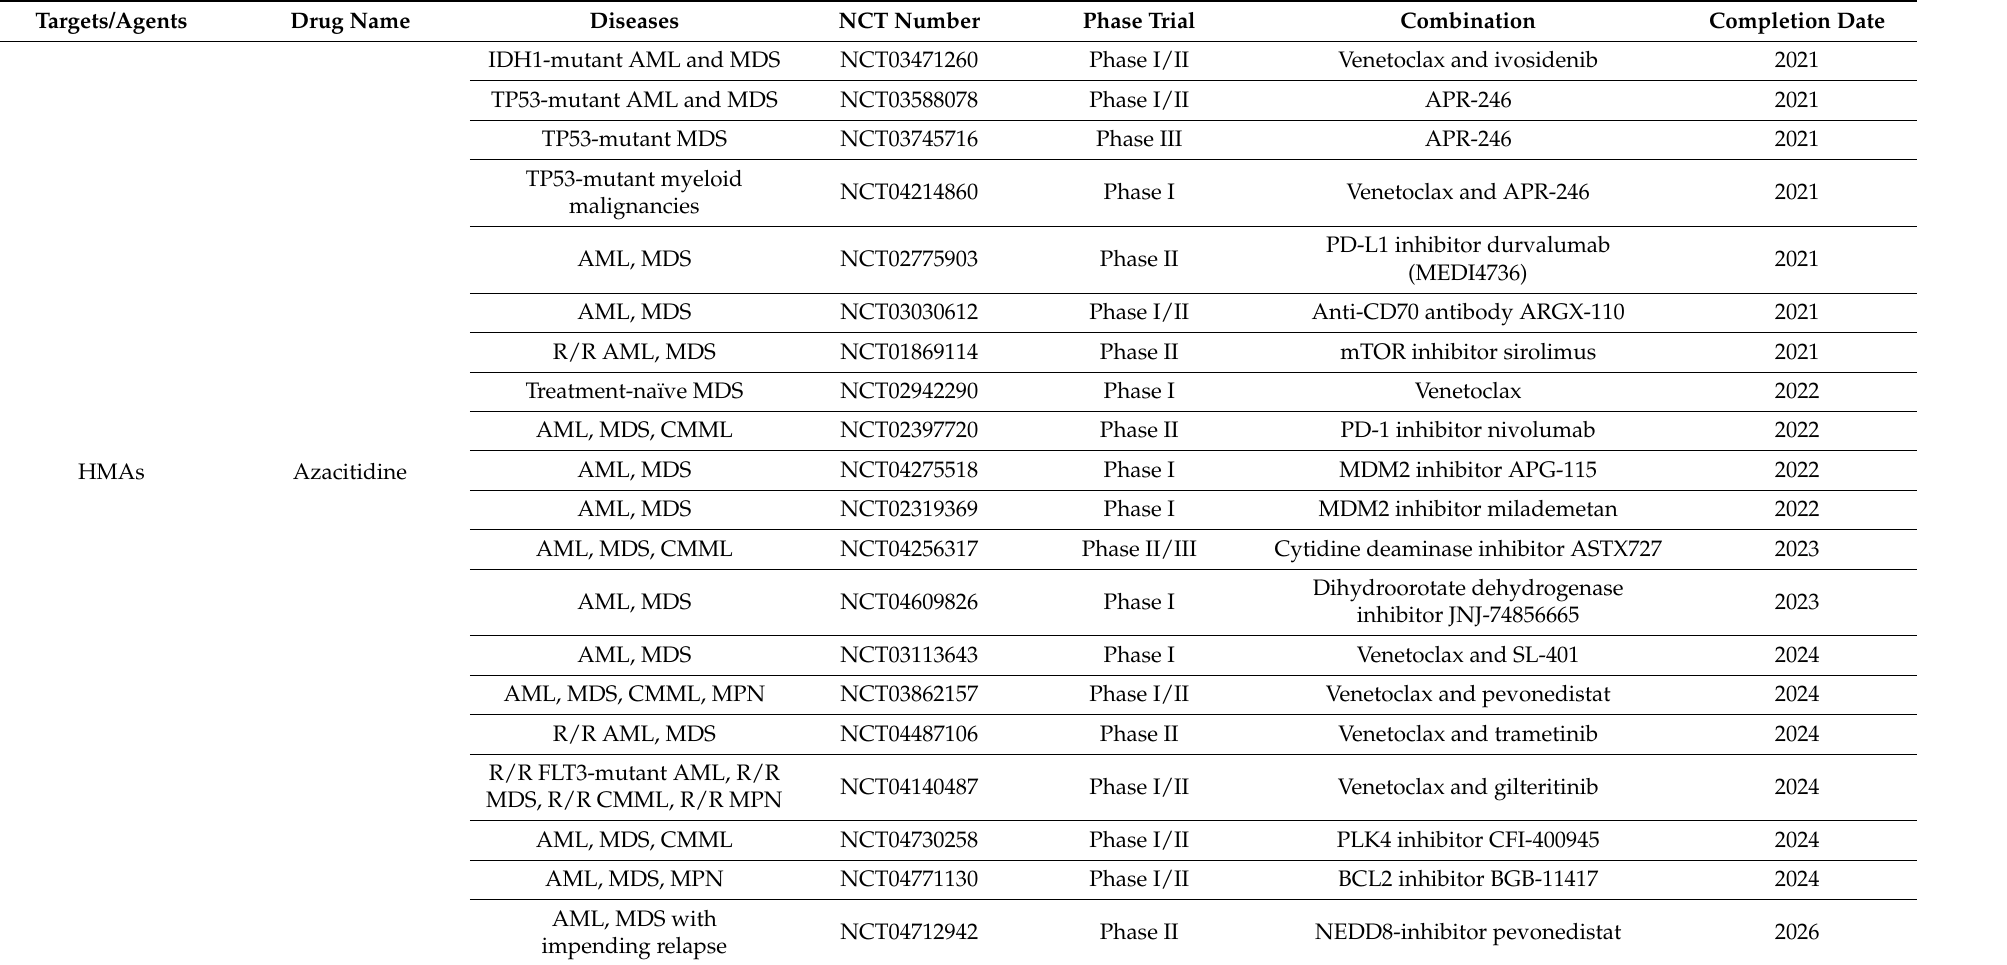
Table 3. Ongoing or recently completed clinical trials using epigenetic drugs in the treatment of myeloid malignancies. Allo-HSCT, allogeneic hematopoietic stem cell transplantation; AML, acute myeloid leukemia; ATRA, all-trans retinoic acid; CMML, chronic myelomonocytic leukemia; DLBCL, diffuse large B-cell lymphoma; MDS, myeloid dysplastic syndrome; MPN, myeloproliferative neoplasms; R/R, relapsed or refractory; sAML, secondary acute myeloid